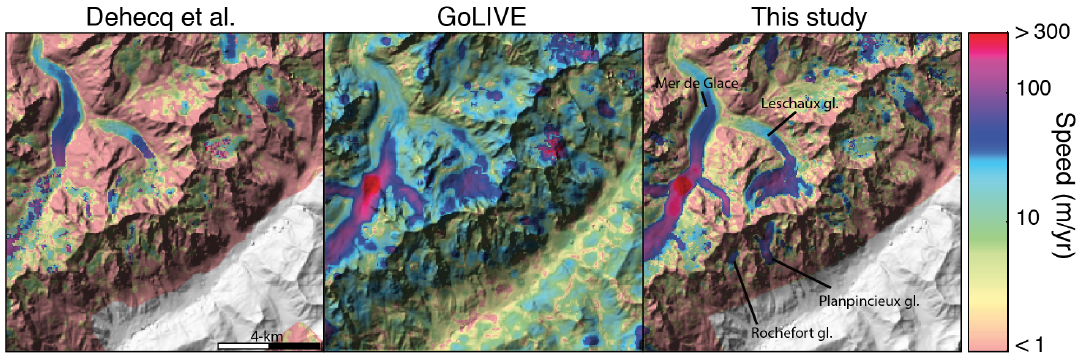
Figure 8. Comparison of glacier surface velocity fields obtained by [38] ( left ), mosaicking of GoLIVE products ( middle ); and our study ( right